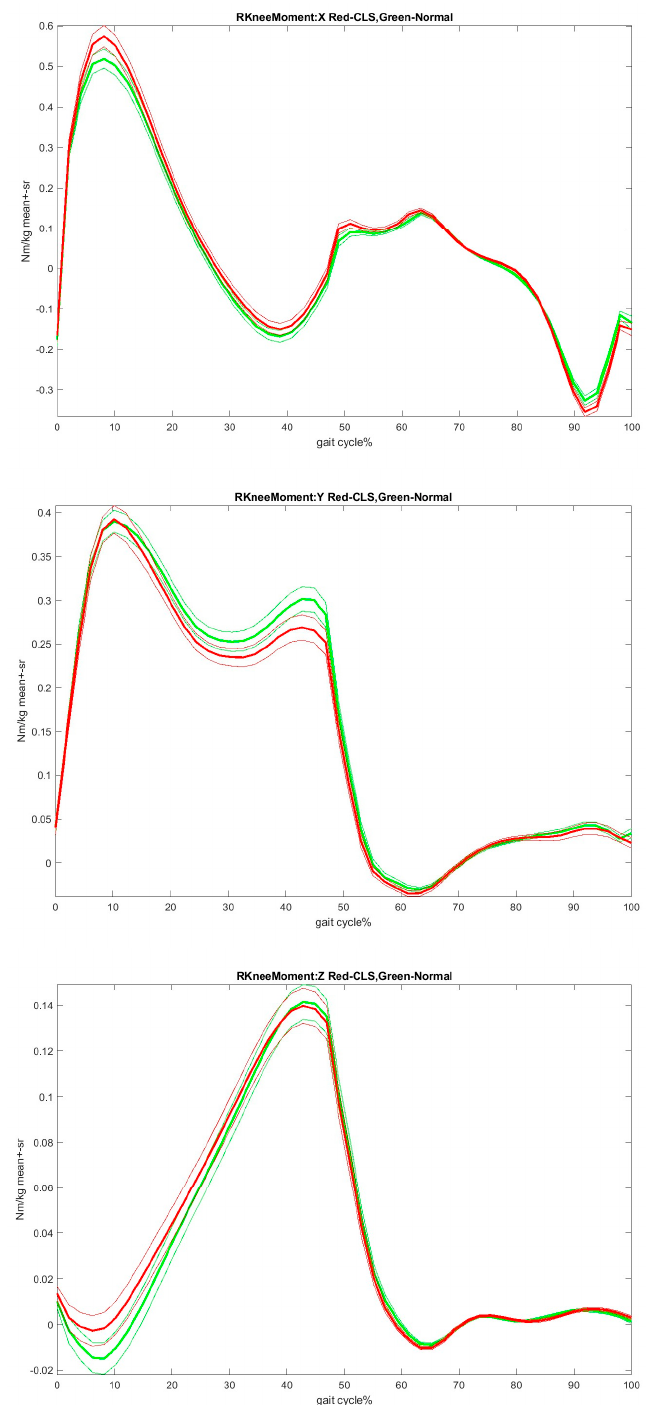
Figure 6. Knee moments’ comparison between before and after CLS in right side. Note: Green: before CLS, Red: after CLS; X, Y, and Z: the sagittal, coronal, and transverse planes. Thickness lines: mean, fine lines: standard error of mean. The curve patterns were plotted using right side 118 pair trials for before and after CLS, and some trails with gaps were removed. As the trails used to plot figures were resampled to 50 frames, there are slightly numeric differences between figures and tables. Nevertheless, the figures show the trends between before and after